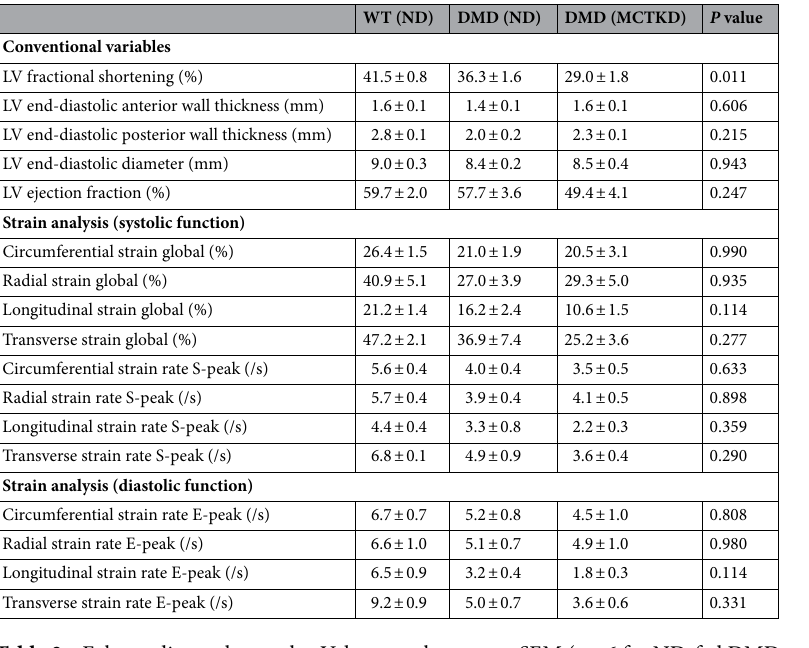
Table.2. Echocardiography results. Values are the mean ± SEM (n = 6 for ND-fed DMD rats, n = 6 for MCTKD-fed DMD rats, n = 4 for WT rats). P value indicates the results of one-way ANOVA followed by the